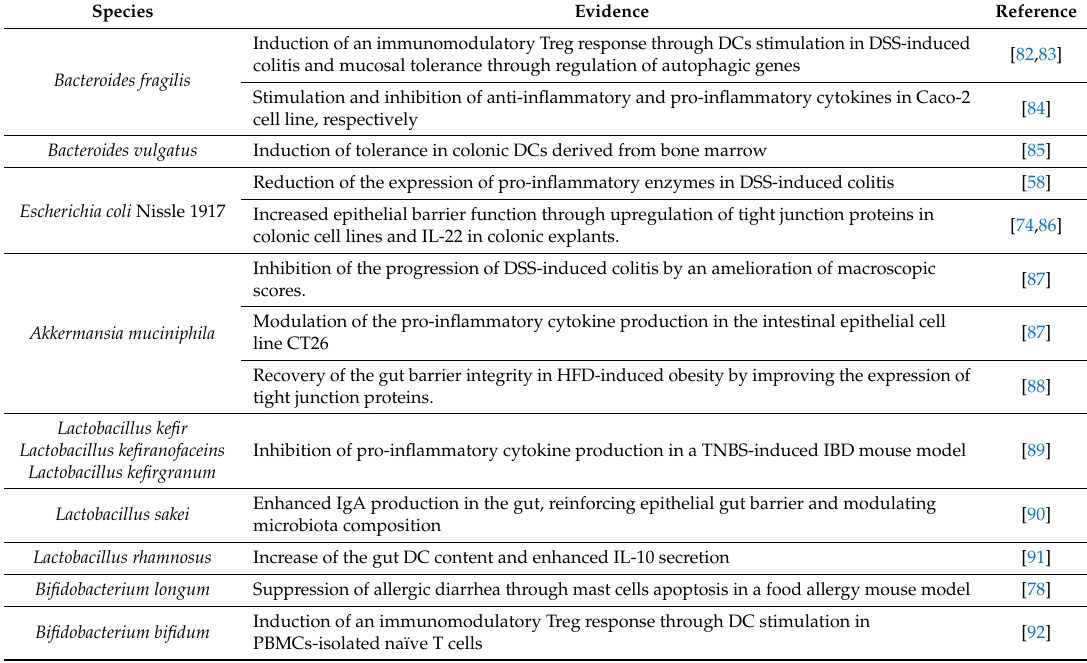
Table 1. Probiotic organisms for which extracellular vesicles (EVs) have been demonstrated to have immunomodulatory properties. DCs: dendritic cells, DSS: dextran sodium sulphate, IL: interleukin, HFD: high-fat diet, TNBS: 2,4,6-trinitrobenzenesulfonic acid solution, IBD: inflammatory bowel